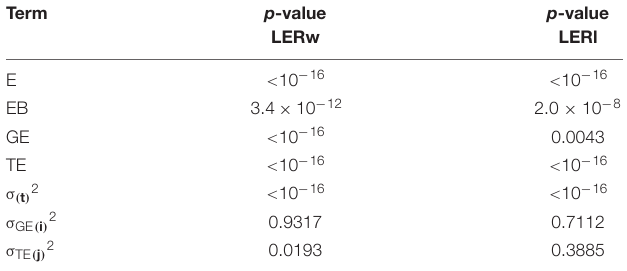
TABLE 4 | p -Values of log-likelihood-ratio tests between reference and test models (see Supplementary Table 1 ) compared to assess the relevance